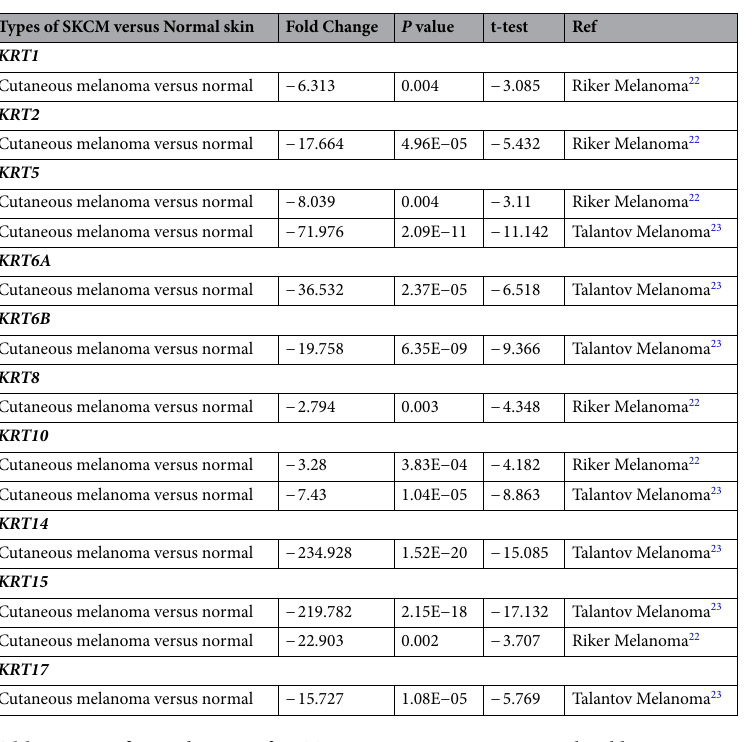
Table 1. Significant changes of KRTs expression in transcription level between SKCM and normal skin tissues (ONCOMINE).